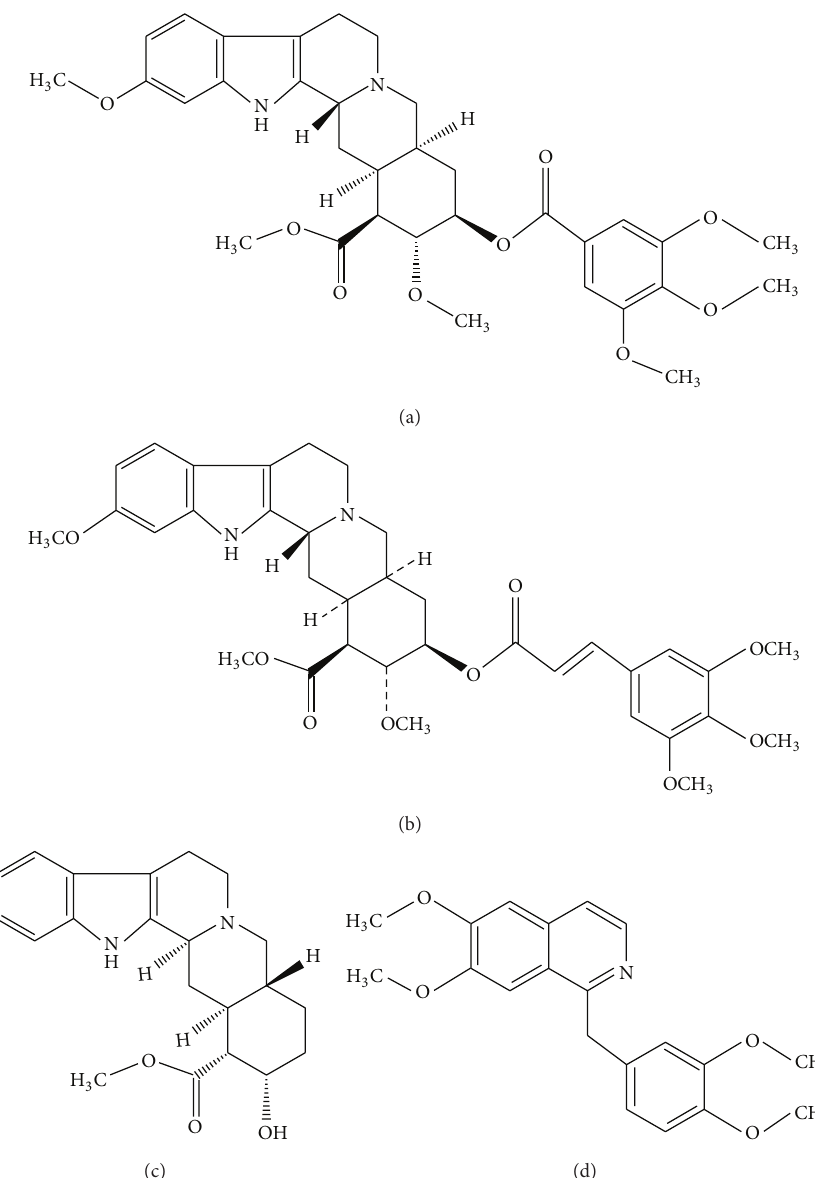
Figure 1: Chemical structure of reserpine (a) rescinnamine (b) yohimbine (c) and papaverine